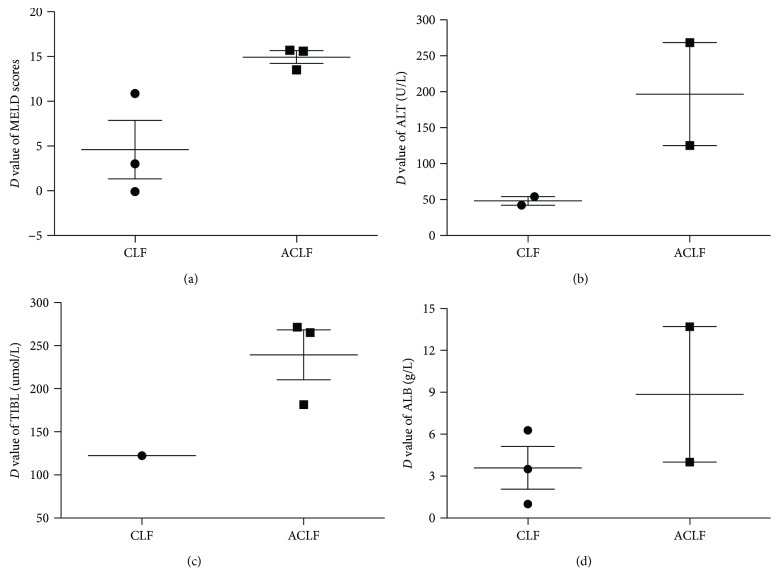
The variations of MELD scores, ALT, TIBL, and ALB between ACLF group and CLF group. (a) The D value of MELD score of ACLF group was higher than CLF group (14.93 ± 1.24 versus 4.6 ± 5.66, P < 0.05); (b, c, d) D values of ALT, TIBL, and ALB had no differences between CLF group and ACLF group, separately.